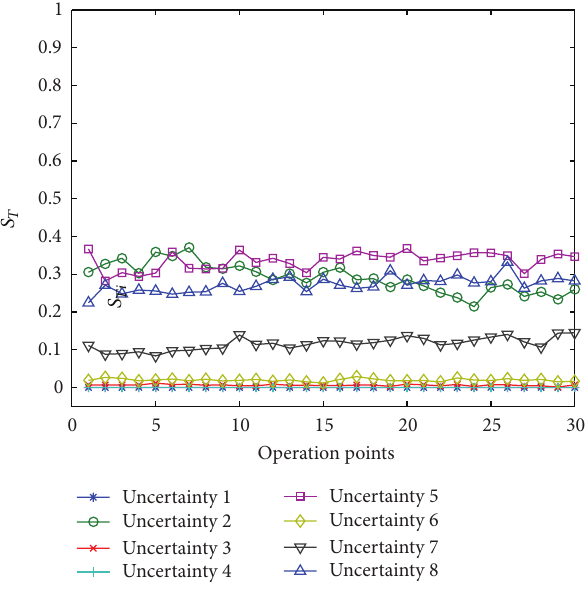
Figure 9: GSA of all operation points.